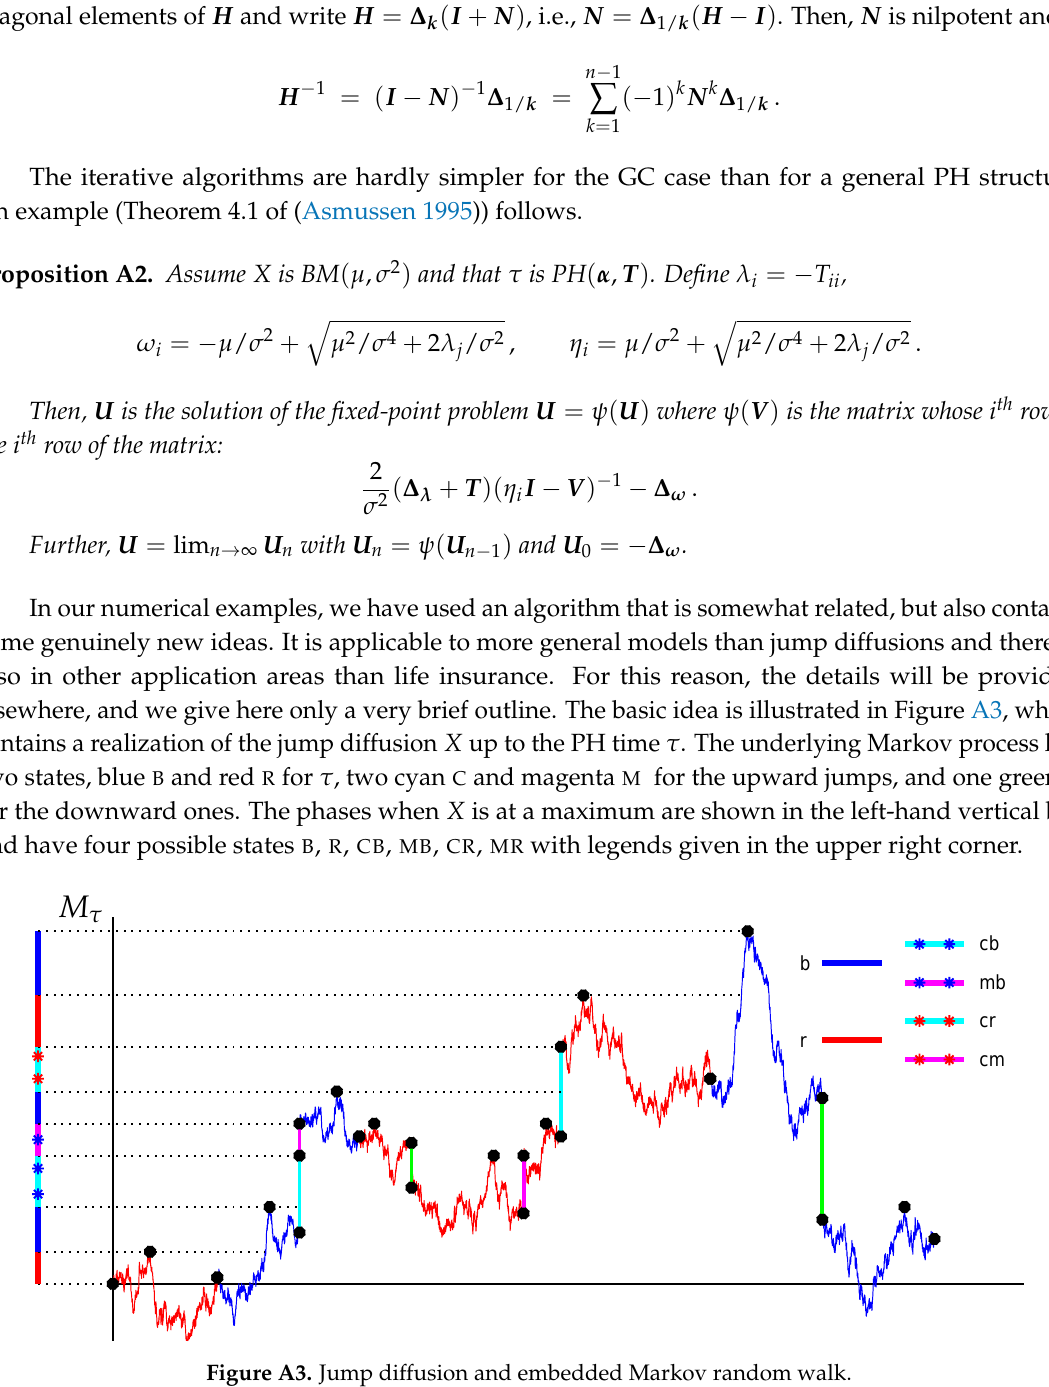
Figure A3. Jump diffusion and embedded Markov random